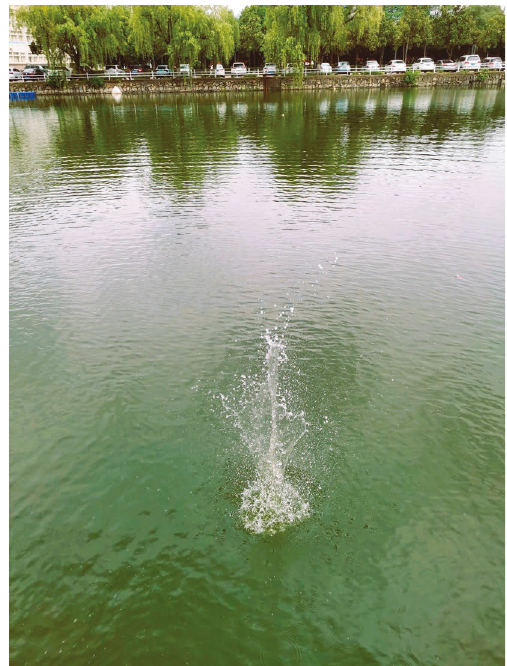
Figure 18: Heavy object falling into water arouses water column diagram.